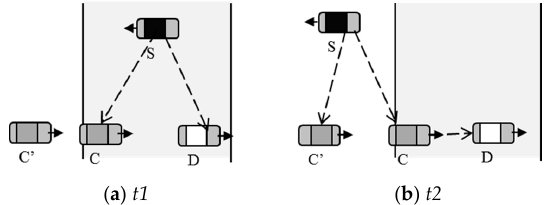
Figure 1. Cooperative downloading using digital fountain code (DFC). ( a ) S sends data to D directly; ( b ) C relays data from S to D when S leaves the communication area of D .